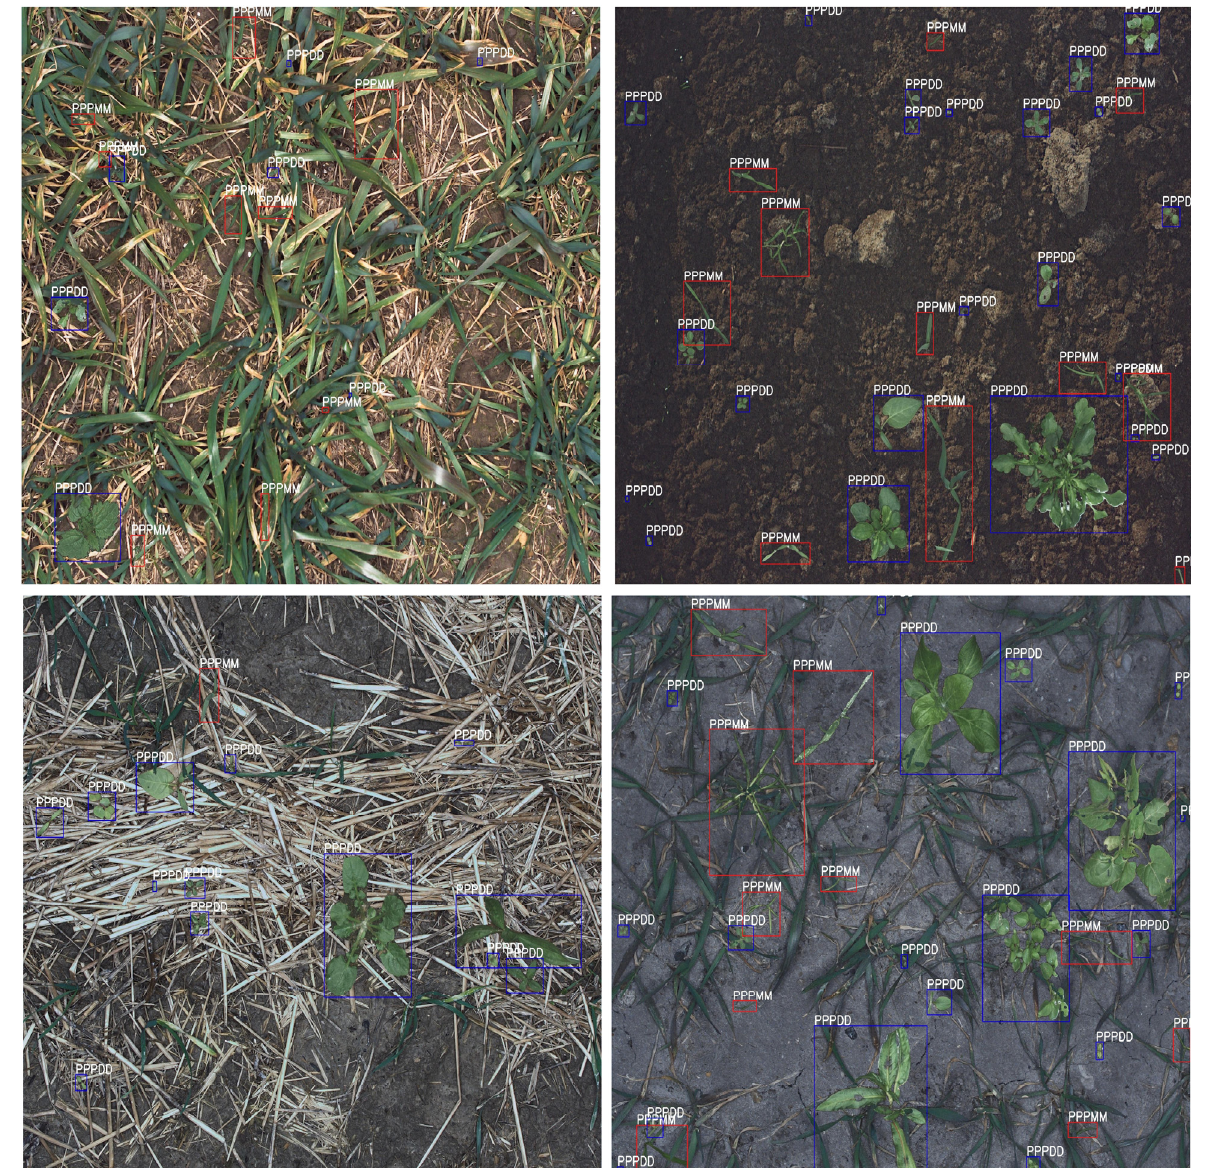
Figure 3. Synthetic images with labels generated by the developed image processing algorithm red (PPPMM) and blue (PPPDD) bounding boxes represent monocot/dicot classes, respectively.